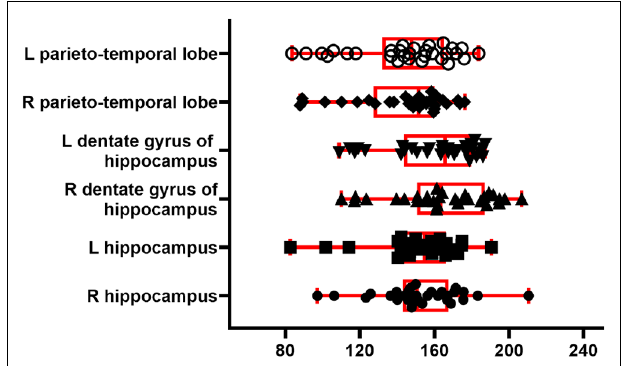
FIGURE 7 | CBF from 30 C57BL/6J mice. Boxplot shows median, interquartile range, upper and lower adjacent values for six brain region. Each dot represents regional CBF in ml/100g/min from one